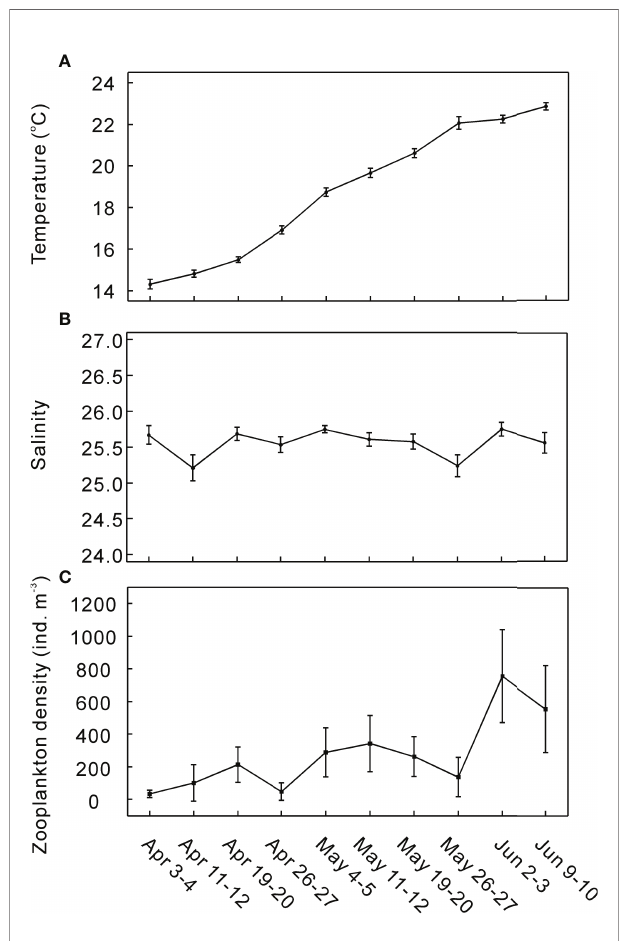
FIGURE 2 | Temporal variation of water temperature (A) , salinity (B) and zooplankton density (C) in XSB. Error bars represent standard